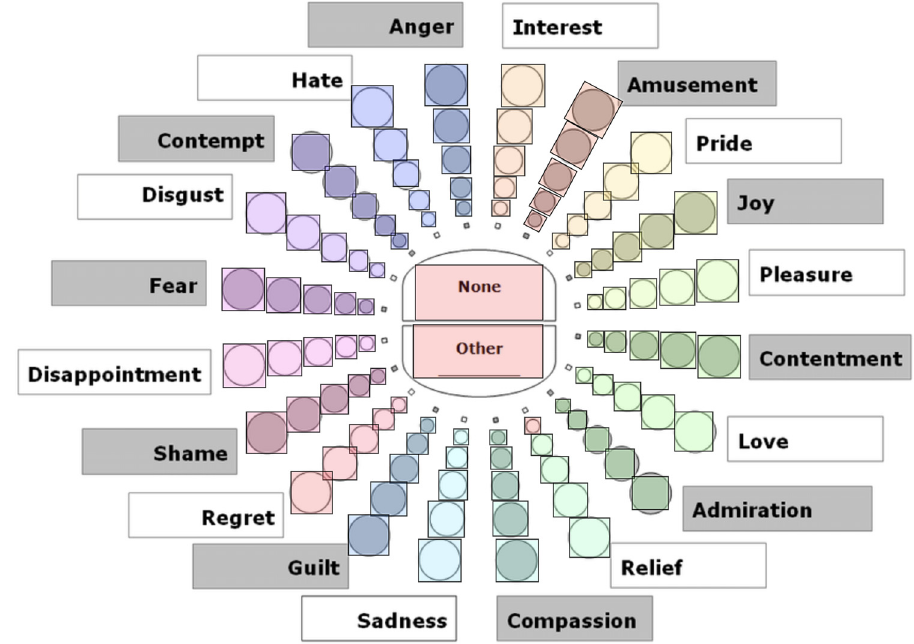
Figure 2: Geneva emotion